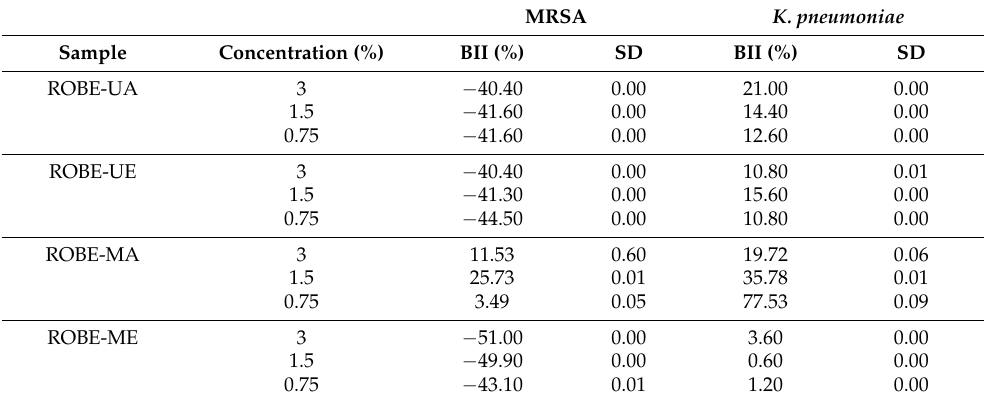
Table 4. The effect of ROBE on bacterial biofilm